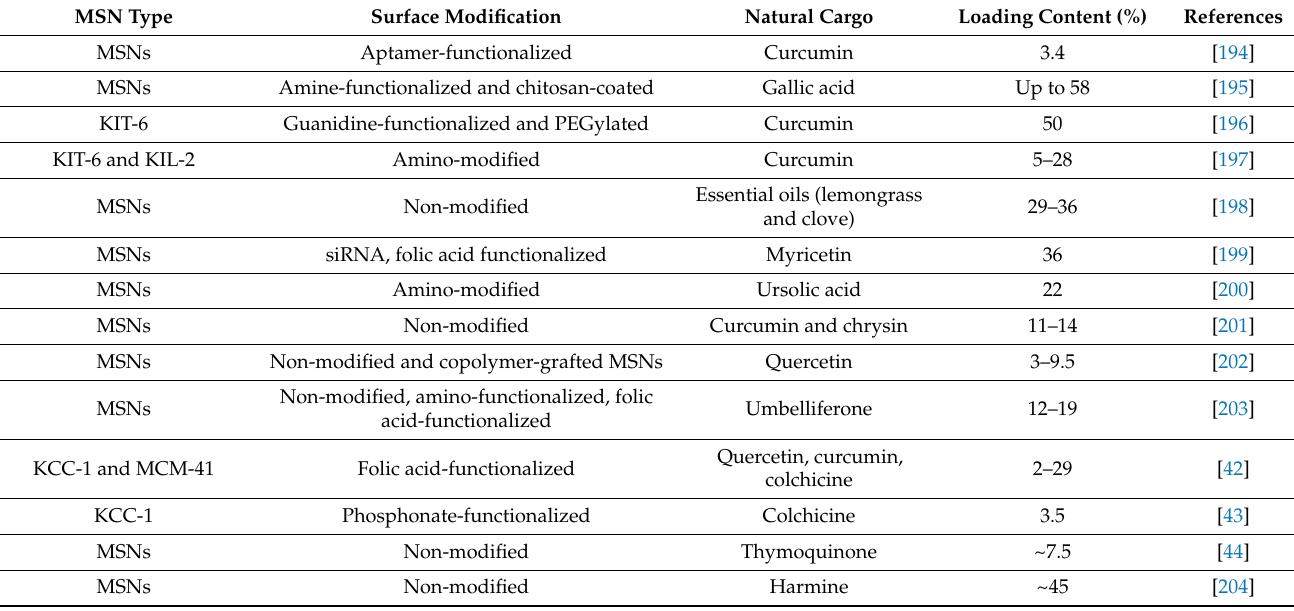
Table 5. Loading capacity for natural prodrugs into MSNs established as recent drug delivery systems for natural medicinal